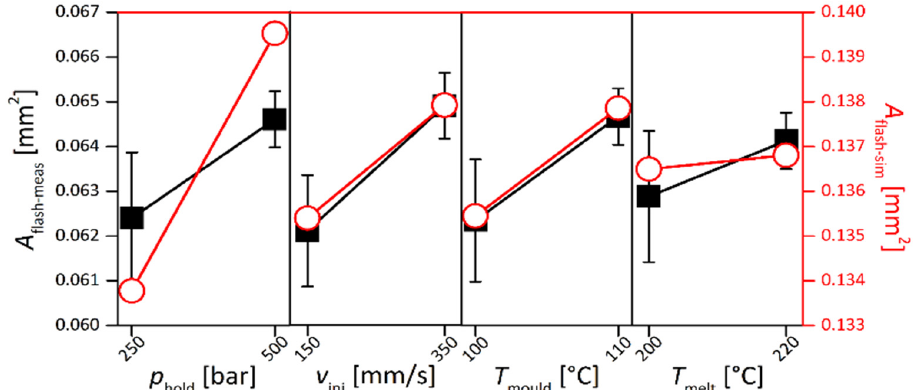
Figure 10. Main effects plot of the flash area for the experiments A flash-meas (in black) and simulations A flash-sim (in red). Note that the scales for the two sets of results are different, but the ranges shown are equal. Interval bars represent the standard errors of experimental data [31].